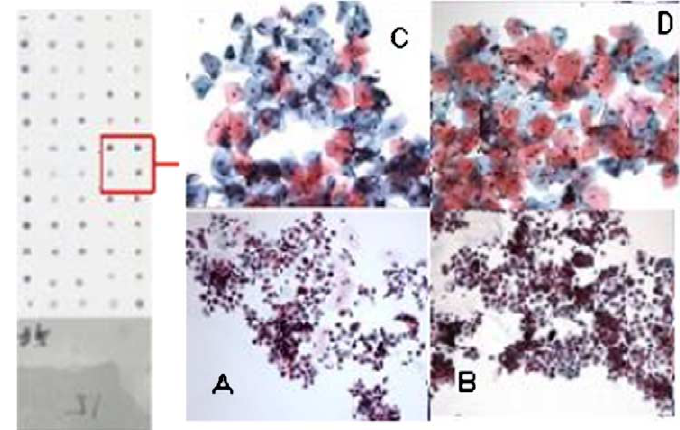
Fig. 11. Percentage of MIB-1 positive cells in relation to the total number of cells within each spotted cell